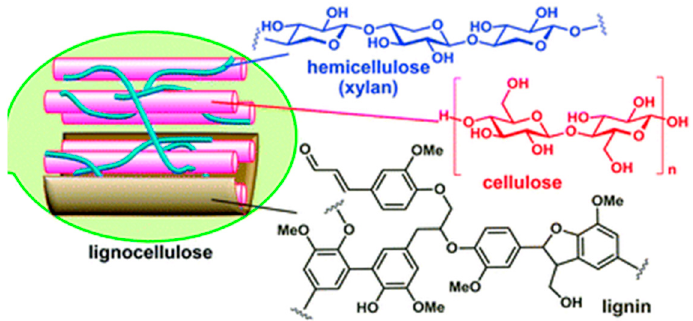
Figure 1. primary reaction pathways A and B for the formation of HTC-coal (modified from [6]). A is a path via polymerization of solved molecules, B is a solid-to-solid conversion. The SEM pictures show hydrochar from glucose ( left ) and lignin ( right ).